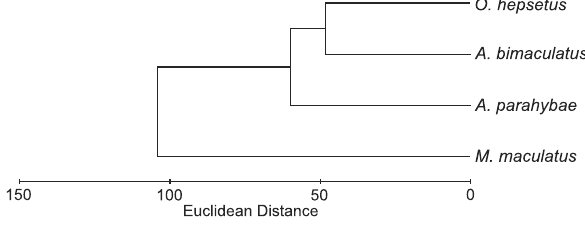
Figure 2. Dendrogram from cluster analysis on Index of Feeding Importance for the four examined Characiformes fish species in Lajes Table II. Index of Feeding Importance for feeding item of the four examined Characiformes fish species in Lajes Reservoir. Number of examined individuals for each species = 45. Main items are show in bold.